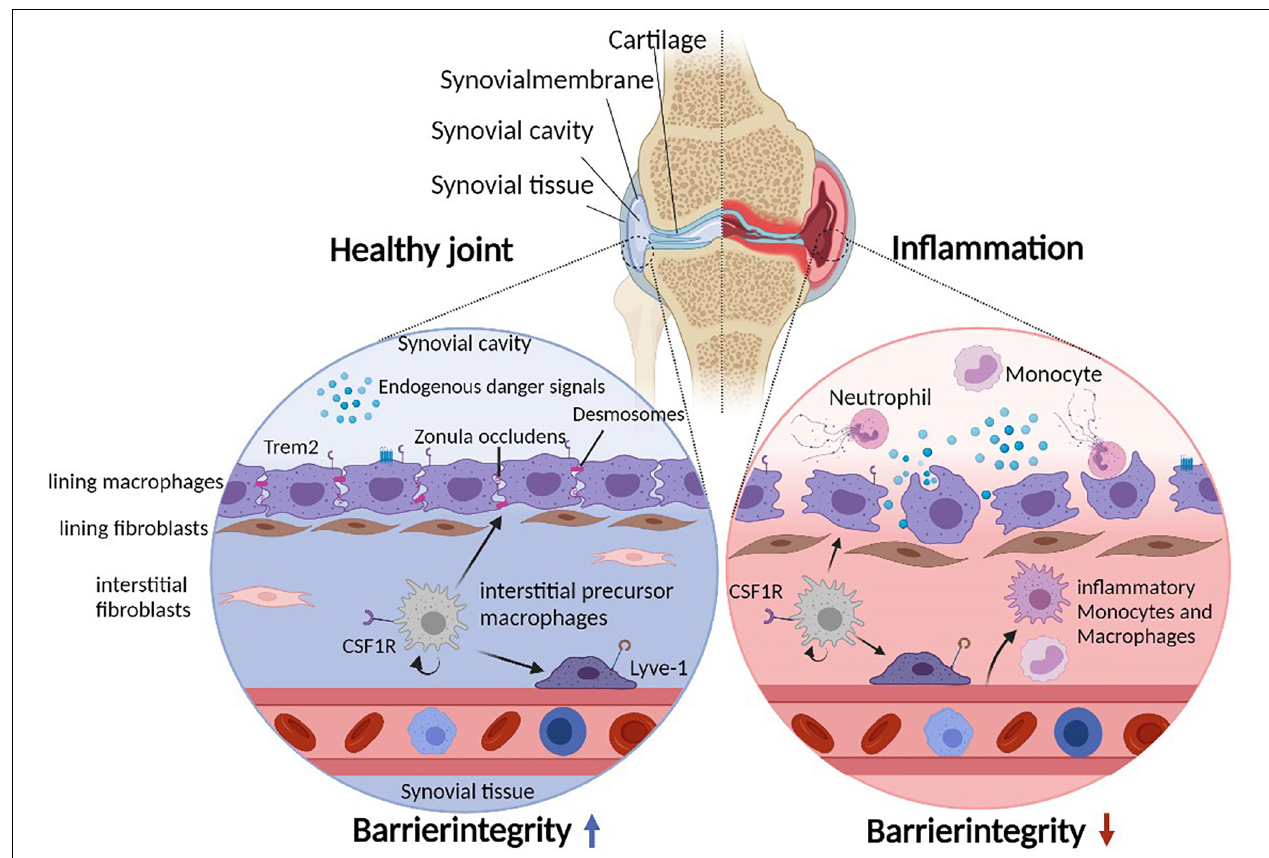
FIGURE 1 | Cellular heterogeneity of the synovial microenvironment. Due to constant mechanical stress, the synovial cavity harbors endogenous danger signals. The synovial lining layer separates the synovial cavity from the tissue and consists of lining macrophages and fibroblasts. Lining macrophages express Trem2 and tight junctions (Zonula Occludens) as well as desmosomes, allowing maintenance and integrity of the synovial barrier. In addition, the subling interstitial tissue hosts various interstitial macrophage (and fibroblast) populations. During joint inflammation such as in patients suffering from rheumatoid arthritis, the lining integrity is disrupted and inflammatory immune cells infiltrate the tissue and the cavity. Under such inflammatory conditions, lining macrophages change their morphology to a phagocytic